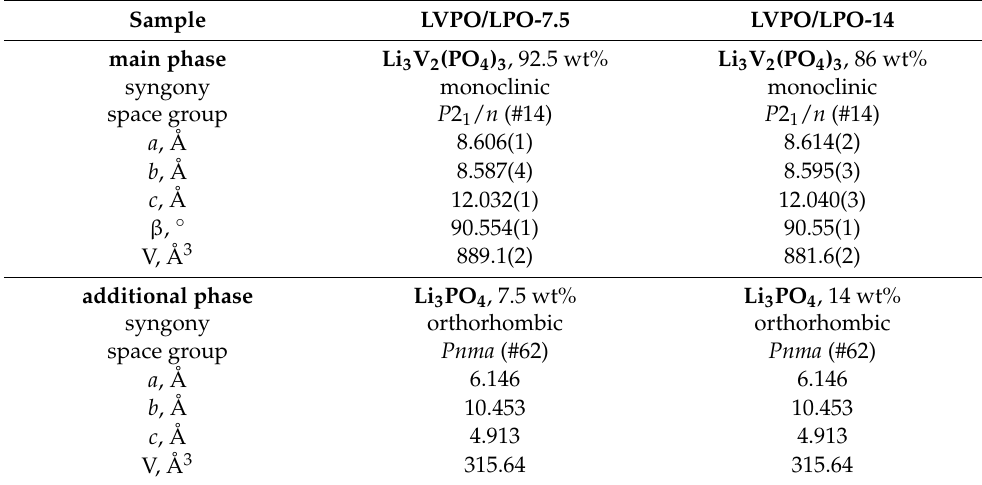
Figure 1. Experimental, theoretical, and differential X-ray diffraction pattern of Li 3 V 2 (PO 4 ) 3 (86 wt%)/Li 3 PO 4 (14 wt%) composite. Table 1. Crystal structure parameters of Li 3 V 2 (PO 4 ) 3 /Li 3 PO 4 composites.